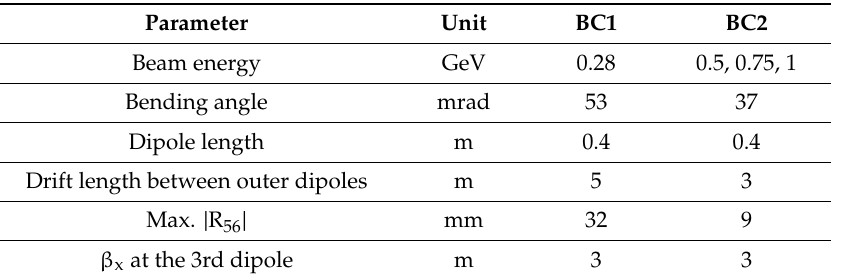
Table 4. CompactLight BC1 and BC2 parameters for the evaluation of the CSR e ff ect on emittance. For other beam parameters, see Table 3.